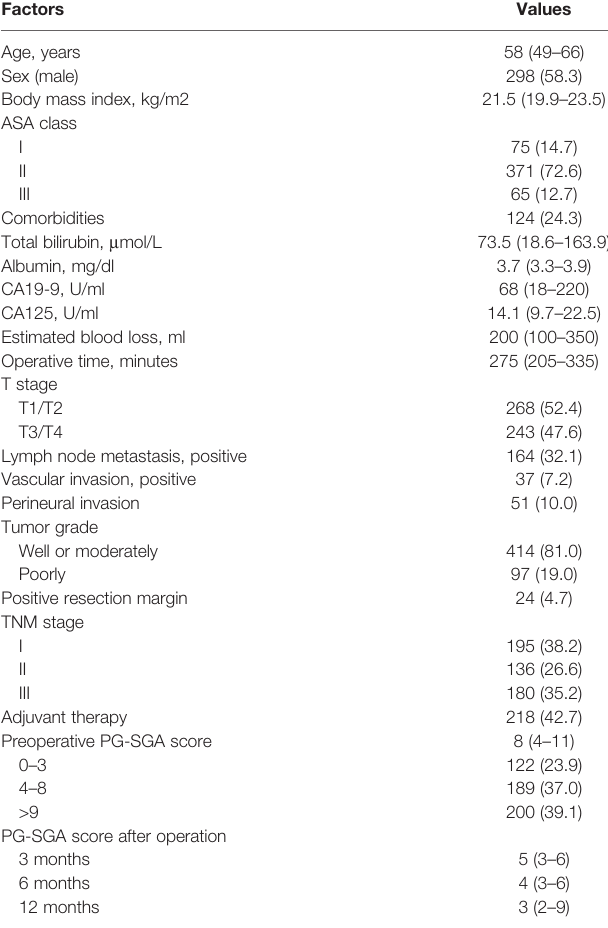
TABLE 1 | Clinicopathological characteristics of 511 patients who underwent pancreatoduodenectomy for ampullary carcinoma.